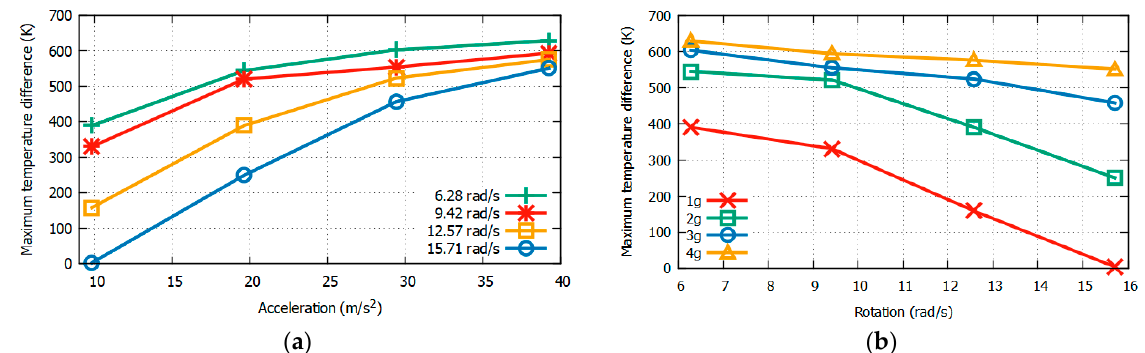
Figure 15. Δ T max at Y sensors w.r.t acceleration ( a ) and rotation ( b ) at varying rotation values by using CO 2 as the gas medium.